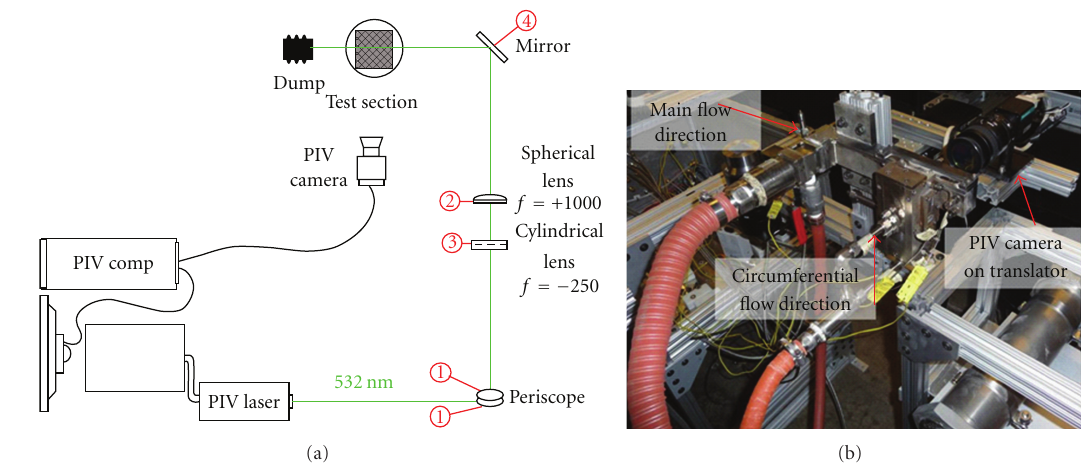
Figure 6: Diagram of PIV experimental setup (a); UCC sector rig (b).